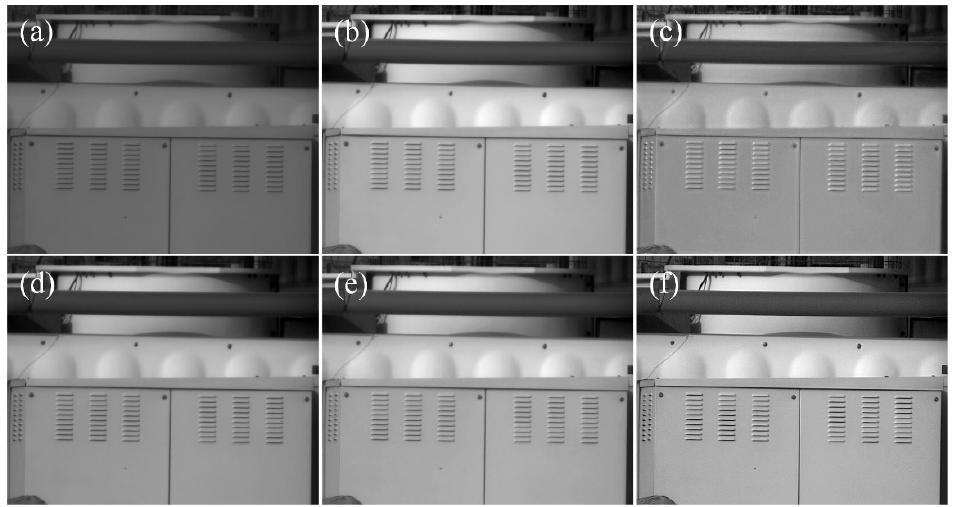
Figure 10. Enhancement results of Image 1: ( a ) input image; ( b ) PE; ( c ) BF&DDE; ( d ) GF&DDE; ( e ) FGF&PE; ( f ) the proposed method.